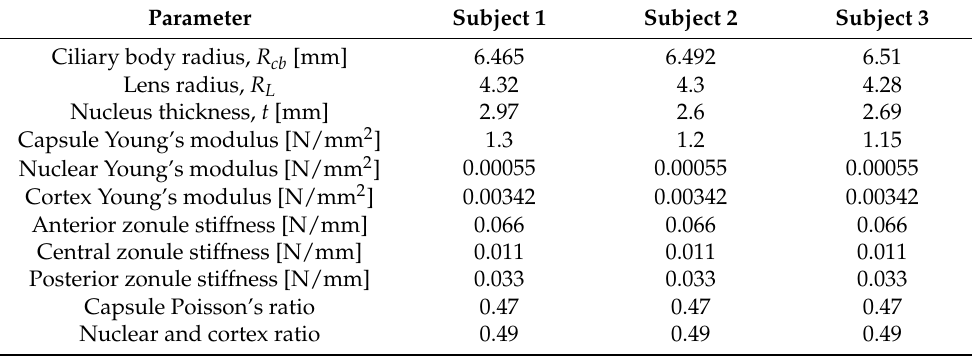
Table 2. Characteristic parameters of personalized lens finite element model.